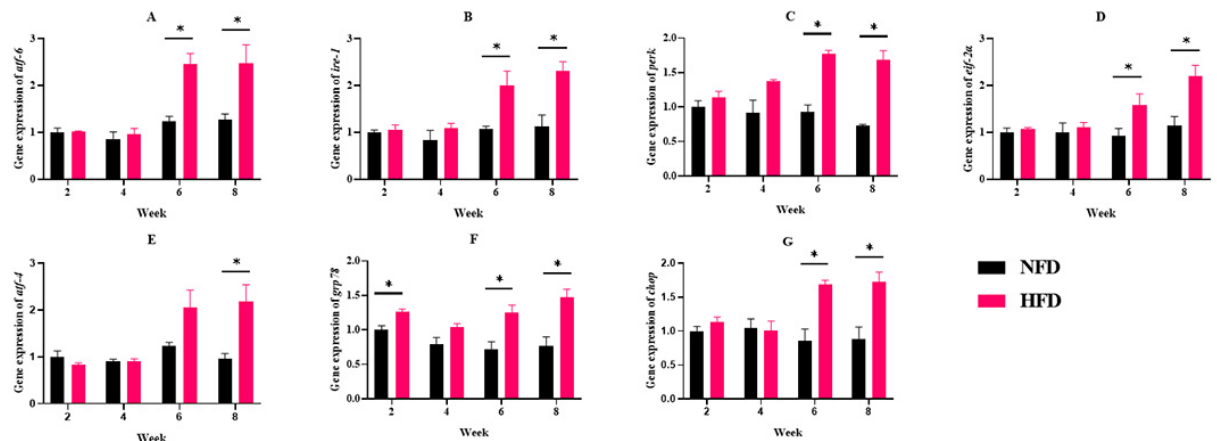
Figure 4. Experiment I. Transmission electron microscopy images of the fish liver at the 2nd, 4th, 6th, and 8th week of feeding trial ( n = 3). scale bar = 2.0 μ m; N, nucleus; ER, endoplasmic reticulum; M, mitochondria. Red arrows: damaged endoplasmic reticulum, green arrows: damaged mitochondria.